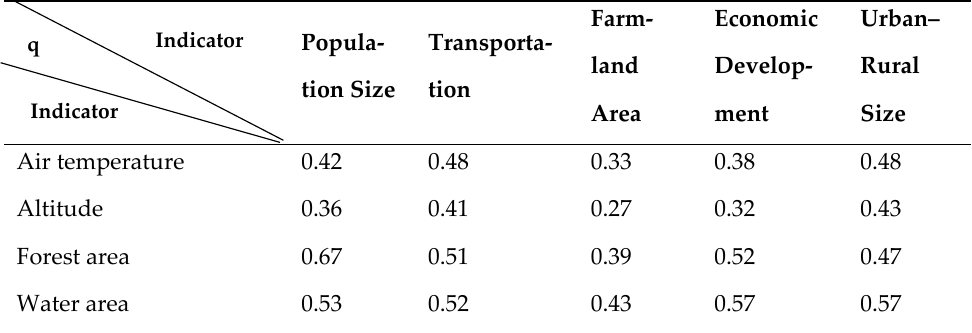
Table 4. The influence of interactions between factors and ICH Distribution.